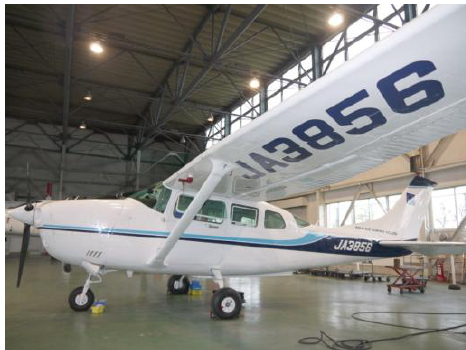
Figure 2. Cessna 206 to install Oblique Camera